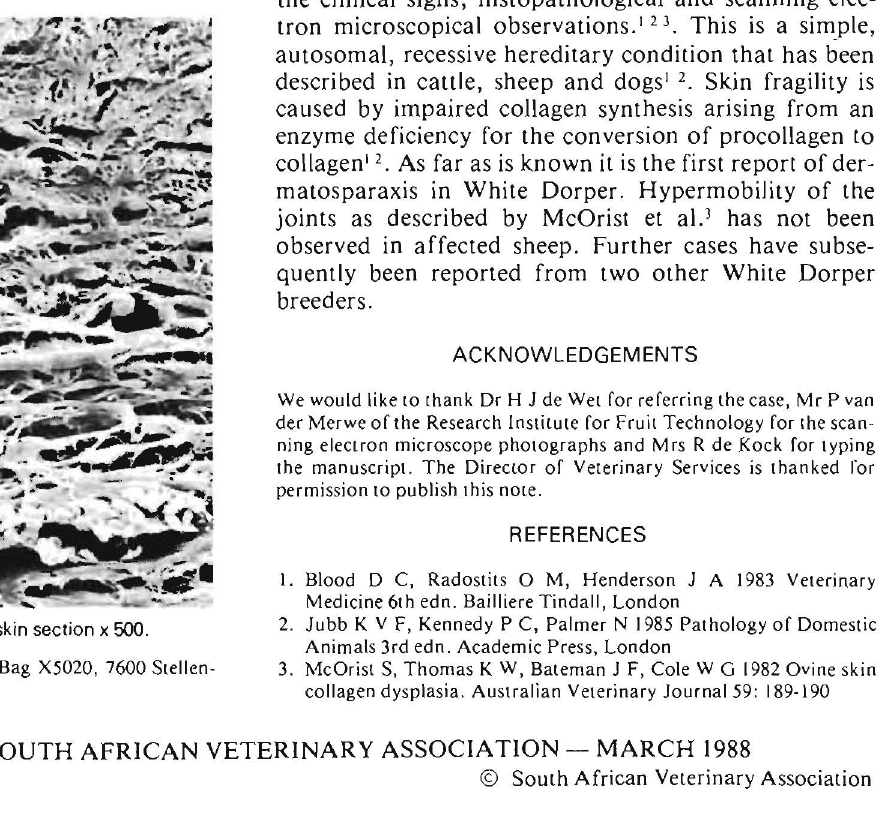
Fig. 1: Dermatosparaxis: SEM photograph skin section x 500.